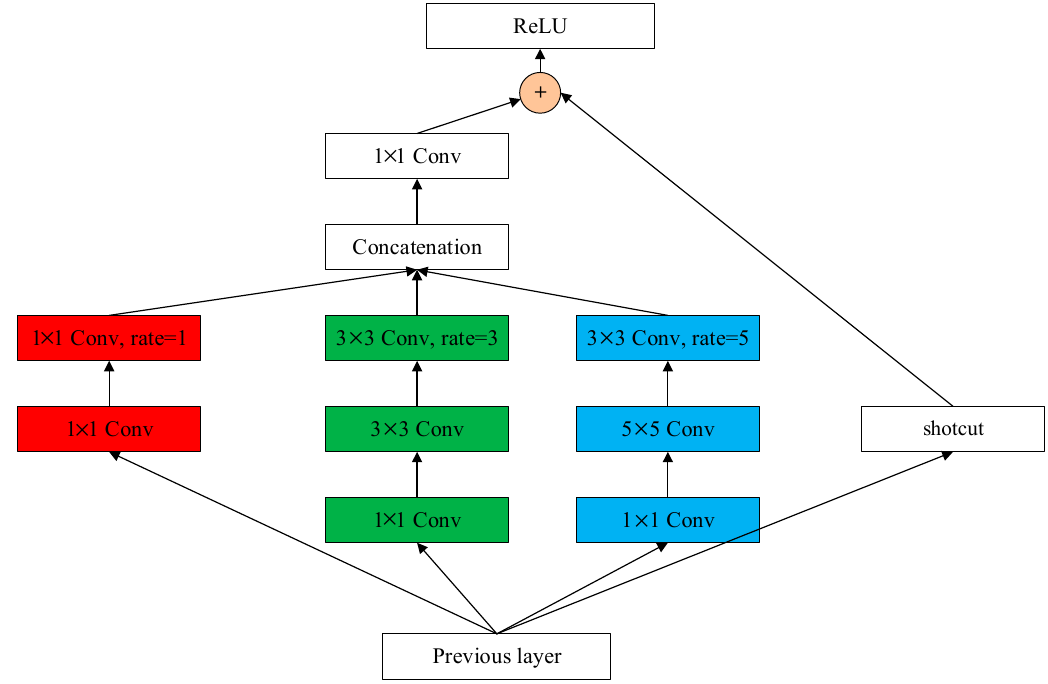
Figure 4. Structure of Receptive Field Block.